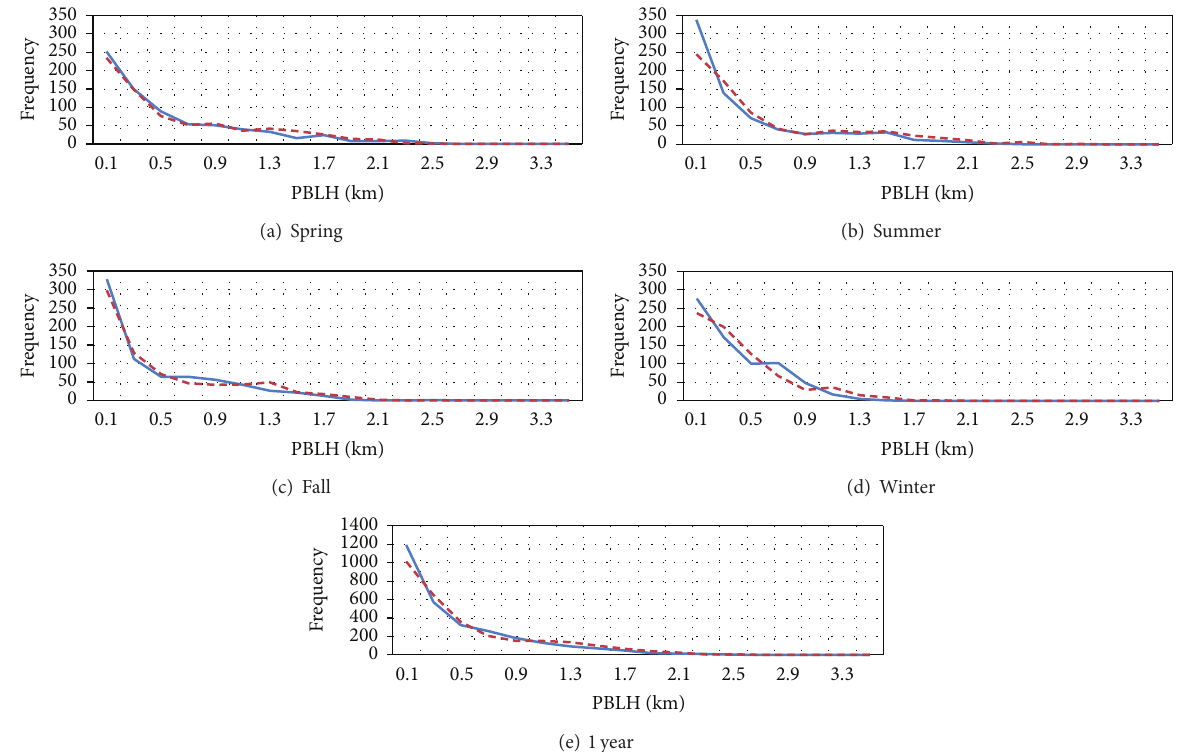
Figure 10: Histogram of model PBLH at Osan and Gwangju for one year (June 2010–May 2011). The solid (dashed) line denotes Osan (Gwangju) site.